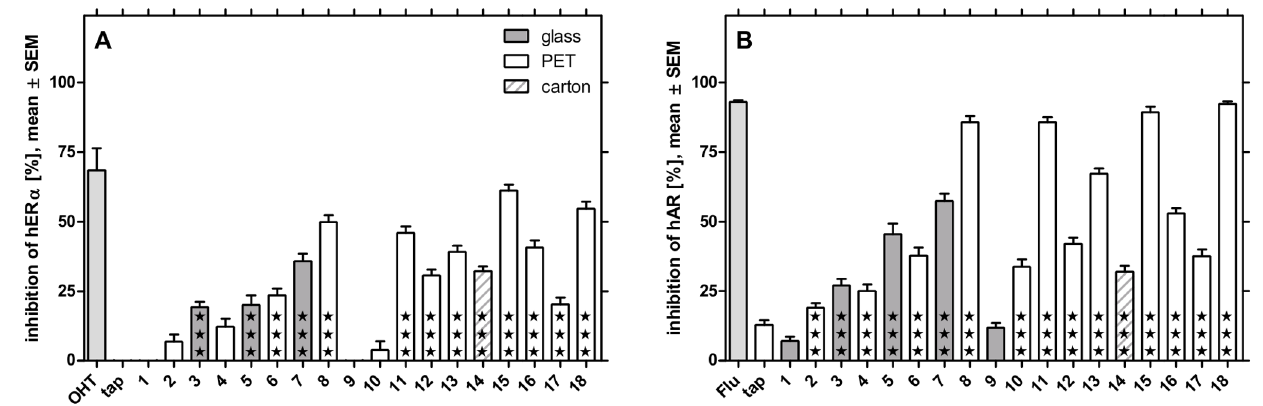
Figure 1. Antiestrogenic (A) and antiandrogenic activity (B) of 18 bottled waters. 13 waters significantly inhibit estrogen receptor alpha, 16 samples antagonize androgen receptor ( www p , 0.0001, compared to controls with endogenous ligand). The activity was normalized to controls containing 17 b -estradiol or testosterone (0% inhibition) and such without (100% inhibition). The results represent three extracts per sample tested in three experiments with eight replicates each.